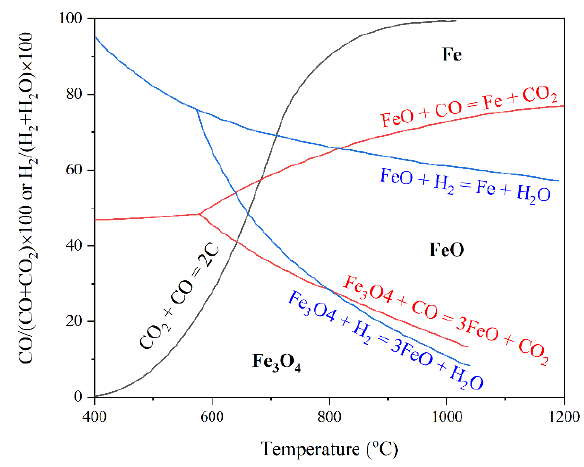
Figure 4. Gas composition in equilibrium with iron and iron oxide phases as a function of tempera- ture [29] “modified”.